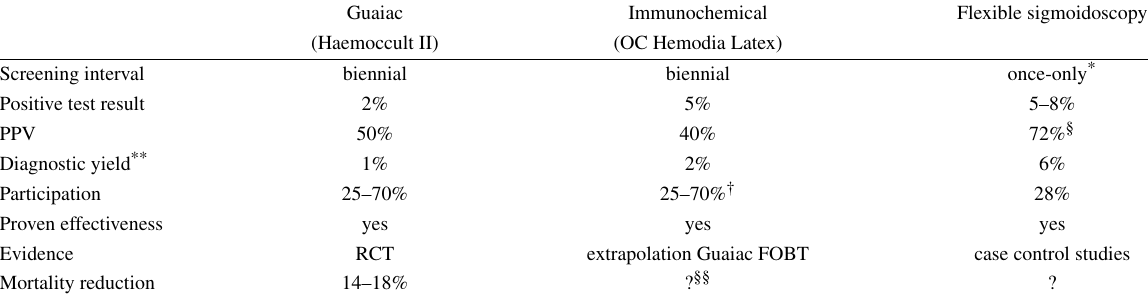
Test characteristics of a FOBT & flexible sigmoidoscopy CRC screening